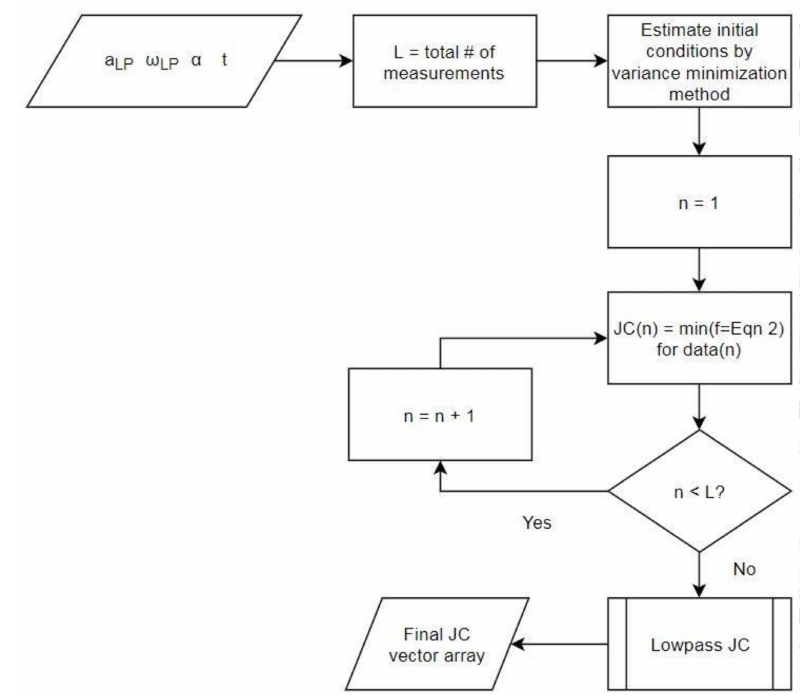
Figure 2. Flowchart representation of the SFO method. The subscript “LP” denotes that the variable has been lowpass filtered, “t” denotes the time vector, “JC” denotes joint center, and “Eqn” denotes